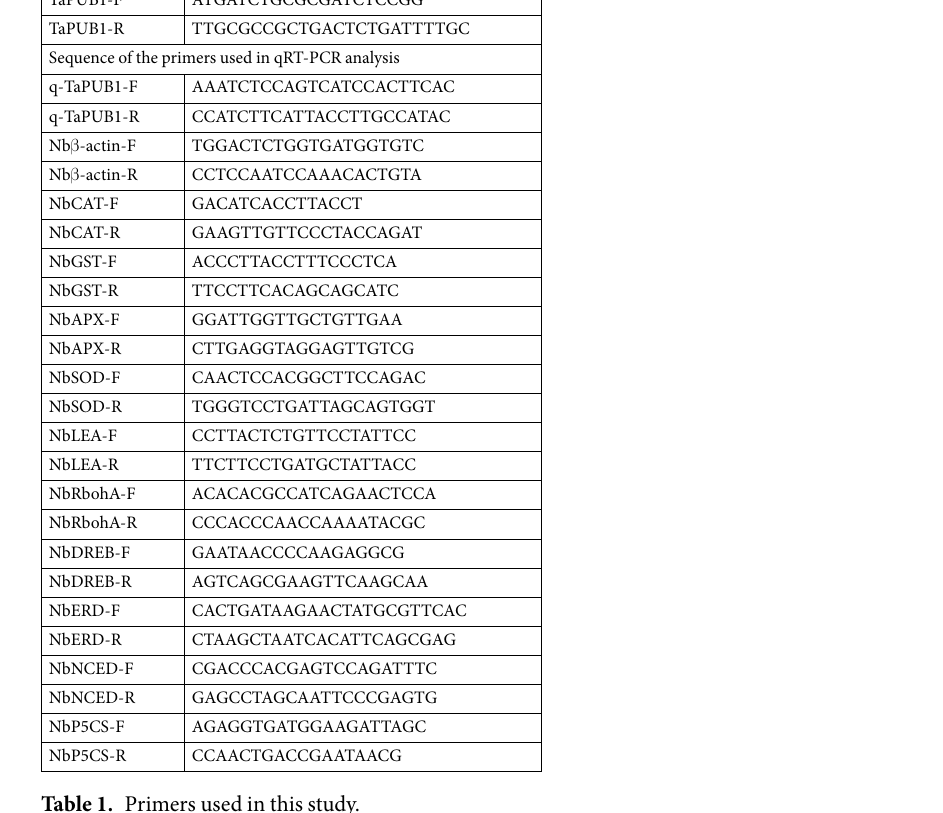
Table 1. Primers used in this